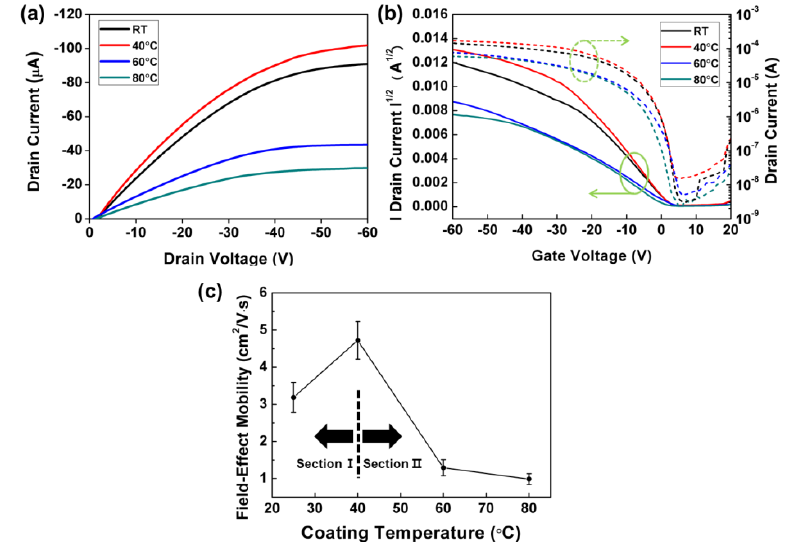
Figure 5. The output ( a ) and transfer ( b ) characteristics curves of TFTs blade-coated with substrate temperature at RT (black), 40 °C (red) 60 °C (blue) and 80 °C (dark cyan), respectively. ( c ) Changes in the magnitude of the average field-effect mobility as a function of different coating temperatures. Table 1. The film and electrical characteristics of the DPP-SVS polymer-based TFTs with different blade- coating temperature